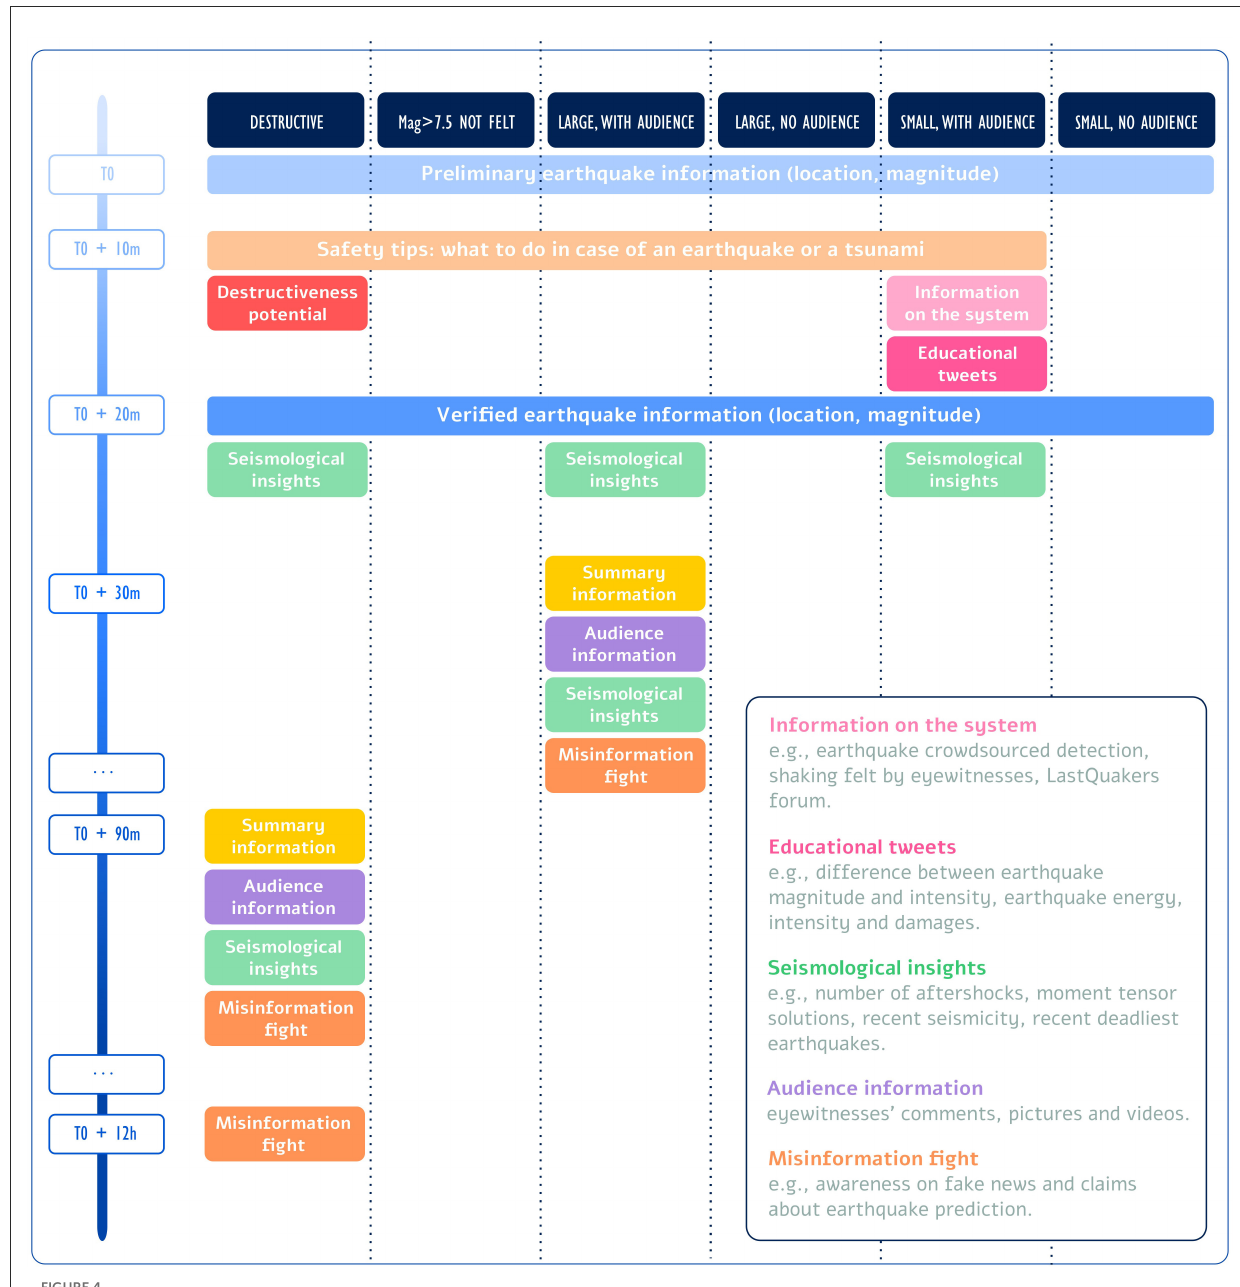
FIGURE4 Schematic view of the possible types of information automatically published by the @LastQuake bot as a function of the classes of earthquakes and time. Large earthquakes are arbitrarily defined as having magnitudes above 4.5. The existence of an audience is defined by the number of collected felt reports (the threshold being set at 50). A specific category of earthquake has been made for unfelt M > 7.5 events which due to their magnitude may still attract public interest. While key information on earthquakes (e.g., parameters) and their effects are systematically published, additional publication parameters are used to avoid repetition of the same tweet within a short period of time. Educational tweets or misinformation debunking ones contain some external resources; some concepts have multiple variations of tweets. Consecutive educational or misinformation fighting tweets are always different. Altogether, the bot can generate 56 different